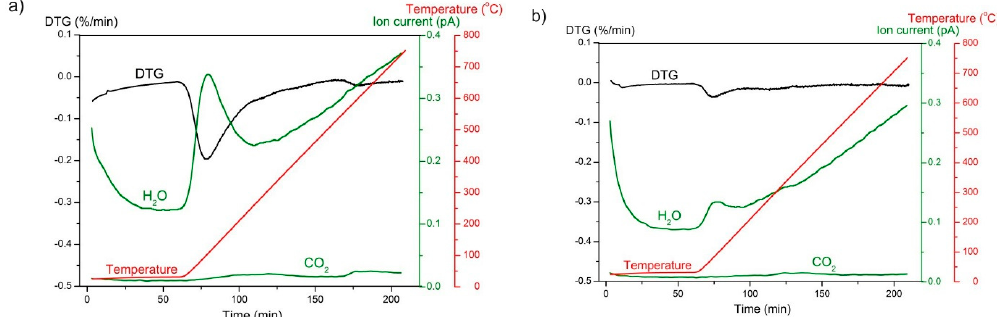
Figure 10. H 2 O and CO 2 ion currents and derivative thermogravimetric (DTG) curves of ( a ) GoHAP-1 (10 nm) and ( b ) GoHAP-6 (40 nm) soaked up to 800 °C. The temperature change as a function of time is also presented.